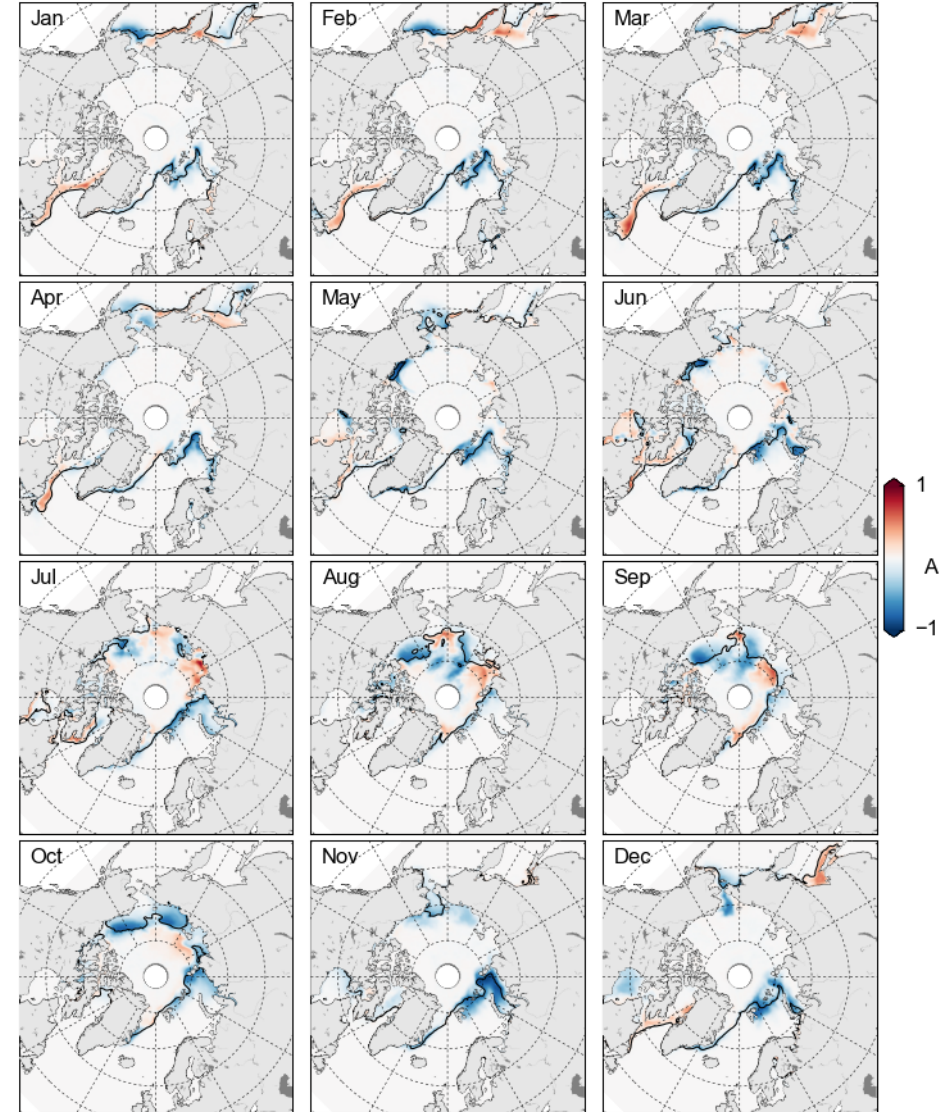
Figure 2. Monthly 2016 sea ice concentration (SIC) anomalies, relative to the 2000–2015 mean, using the Bootstrap algorithm. Note that the SIC data north of 86.5 ◦ N are masked due to the pole hole present prior to 2008. The black contour indicates the monthly 2016 sea ice edge using a 0.15 SIC